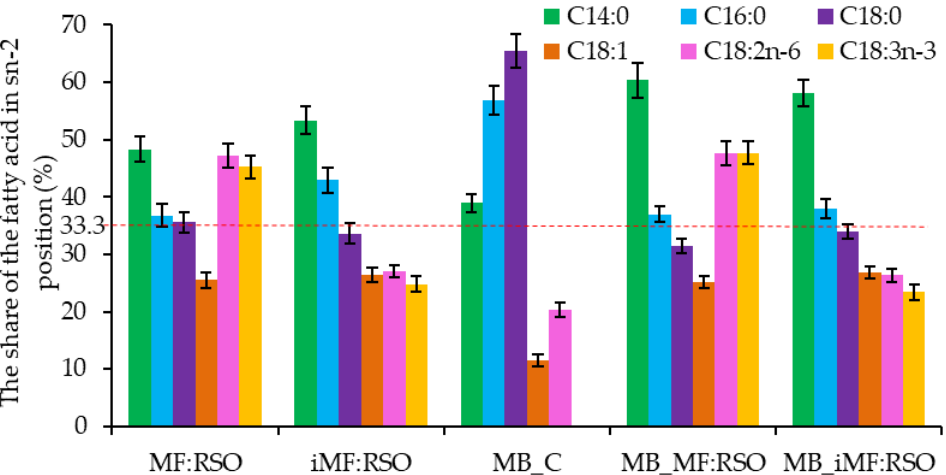
Figure 1. The percentage of fatty acids in the sn-2 position of the initial and interesterified fats and fats extracted from the model meat batters. MF:RSO—noninteresterified mixture of milkfat and rapeseed oil, iMF:RSO—interesterified mixture of milkfat and rapeseed oil, MB_C—control meat batters with pork jowl, MB_MF:RSO—meat batters produced with a noninteresterified mixture of milkfat and rapeseed oil and MB_iMF:RSO—meat batters produced with an interesterified mixture of milkfat and rapeseed oil.